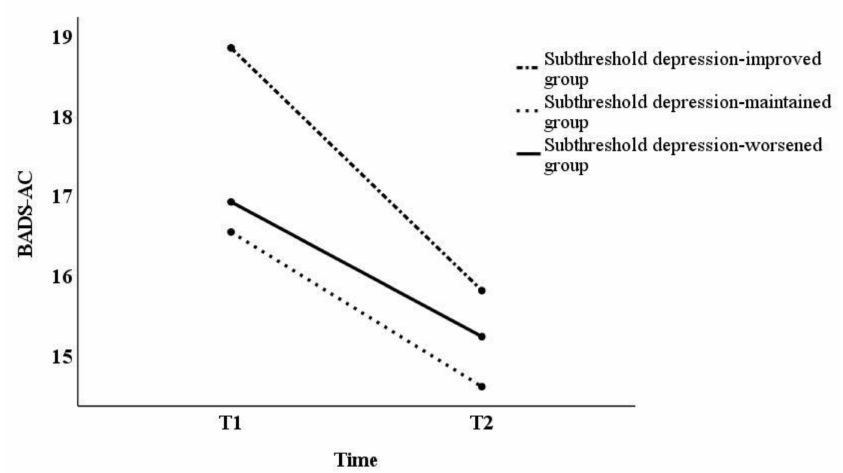
Figure 3. Changes in BADS-AC score from T1 to T2. BADS-AC, Behavioral Activation for Depression